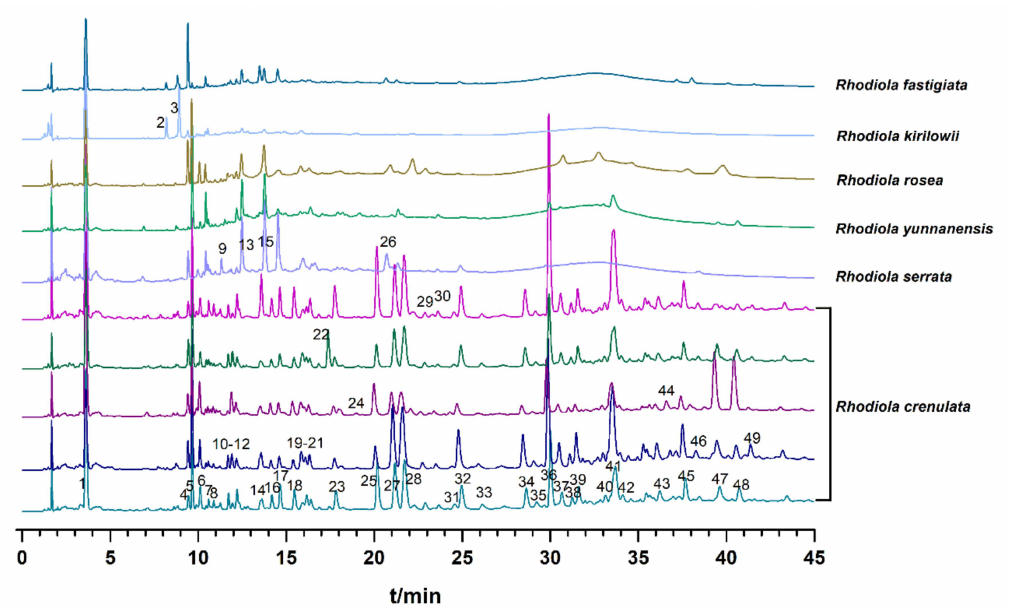
Figure 1. Typical UHPLC fingerprints of Rhodiola from six different species.